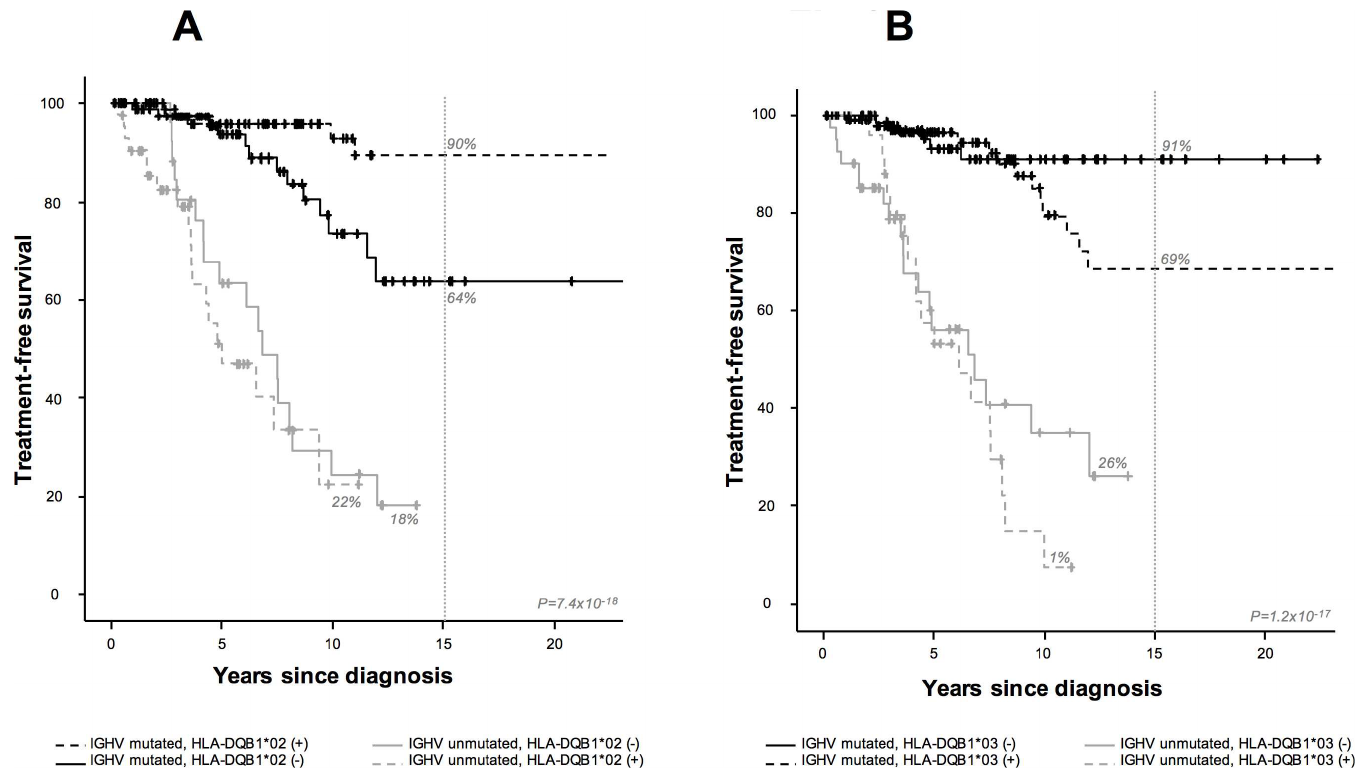
Fig 2. Kaplan–Meier analysis of 15-yeartreatment-free survival (TFS) by HLA alleles and IGHV status. (A) Kaplan–Meier analysisof 15-year treatment-free survival (TFS) by HLA-DQB1 * 02and IGHV status (mutated vs. unmutated). (B) Kaplan–Meier analysisof 15-year treatment-free survival (TFS) by HLA-DQB1 * 03and IGHV status (mutated vs. unmutated). IGHV mutated and unmutatedstatus are depictedby black and gray lines, respectively. The presenceand absenceof the HLA-risk alleleare shown by dashedand continuouslines, respectively. The vertical dashed line indicates15-year follow-